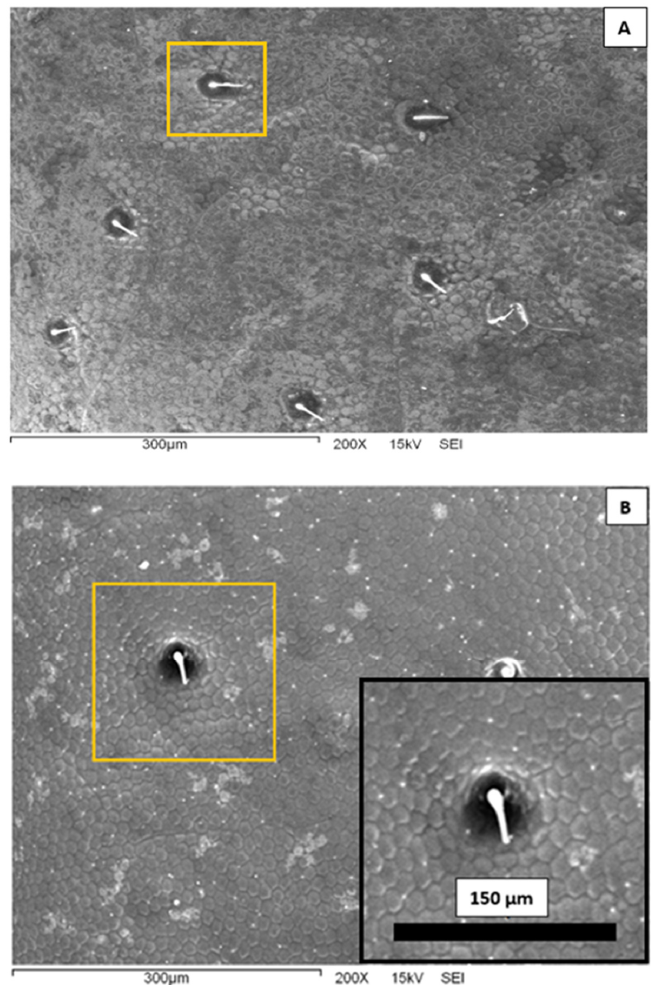
Figure 3. Scanning electron microscopy images of the external surface of a Sonoran Desert beetle at 200× magnification. ( A ) The background is covered with an array of polygons. There are also protuberances in a random distribution. One is highlighted in a yellow square. ( B ) A closer view of the surface. The inset shows a further-amplified protuberance.